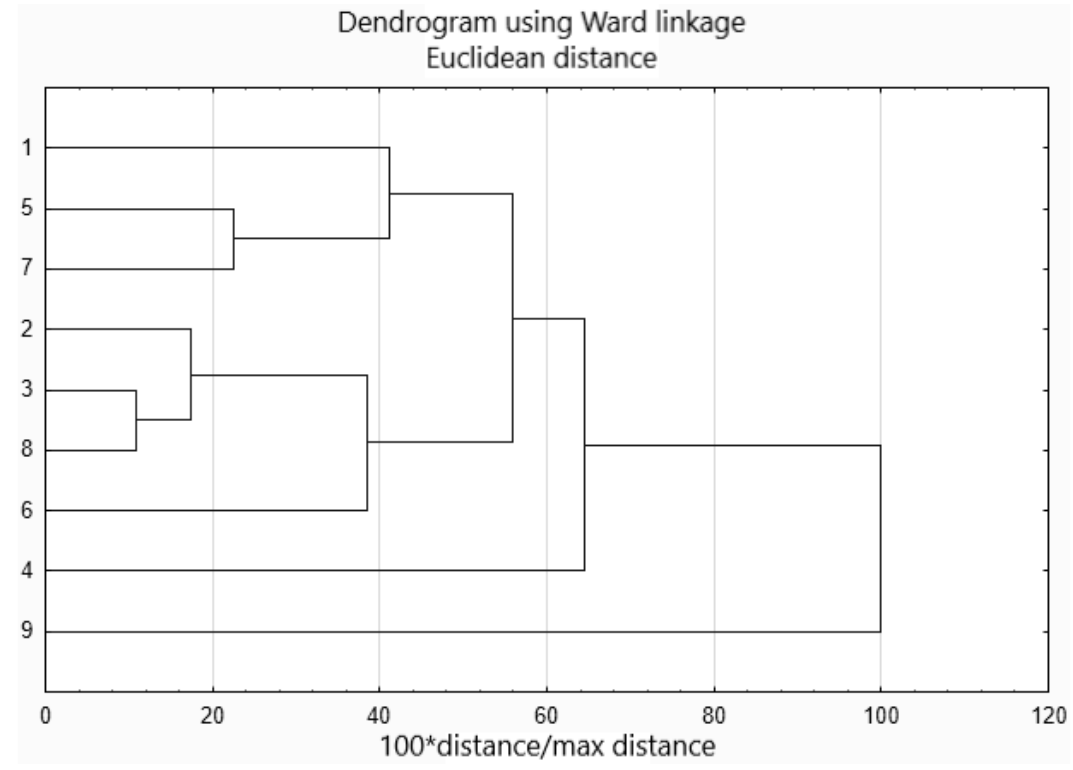
Figure 2. Cluster analysis results of analytical procedures